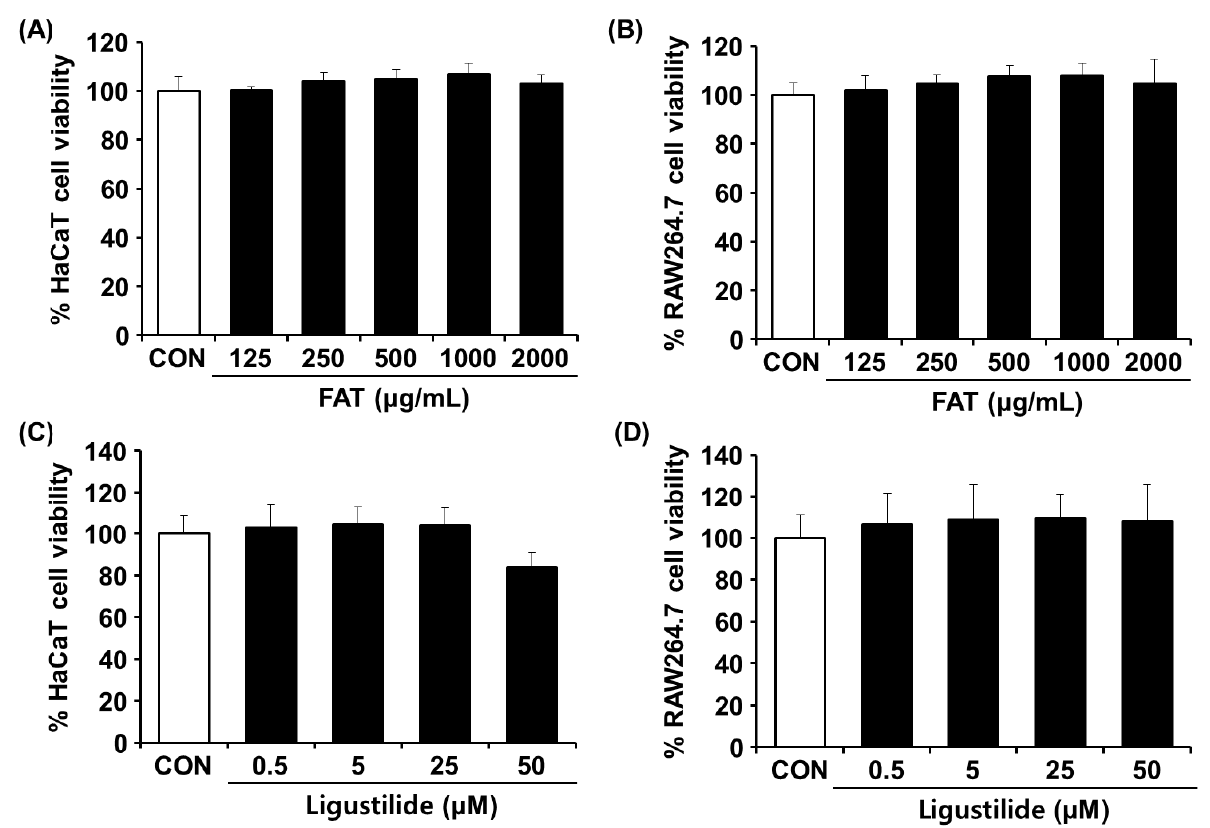
Figure 1. Cytotoxic effects of FAT and ligustilide in HaCaT and RAW264.7 cells. ( A ) HaCaT and ( B ) RAW264.7 cells were treated with FAT (125~2000 ug/mL) for 24 h. ( C ) HaCaT and ( D ) RAW264.7 cells were treated with ligustilide (0.5~50 uM) for 24 h. Cell viability was performed by MTT assay. Data represent the mean ± SD of three independent experiments. Statistical significance was assessed by one-way ANOVA followed by Tukey’s test. FAT; Fermented Angelicae tenussimae with Aspergillus oryzae